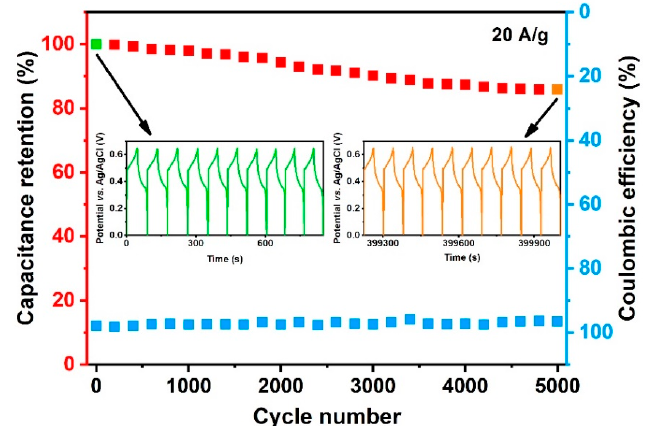
Figure 7. Cycling performance and coulombic efficiency of Co 3 O 4 -2 electrode. The insets are GCD curves at the first and last 10 cycles.